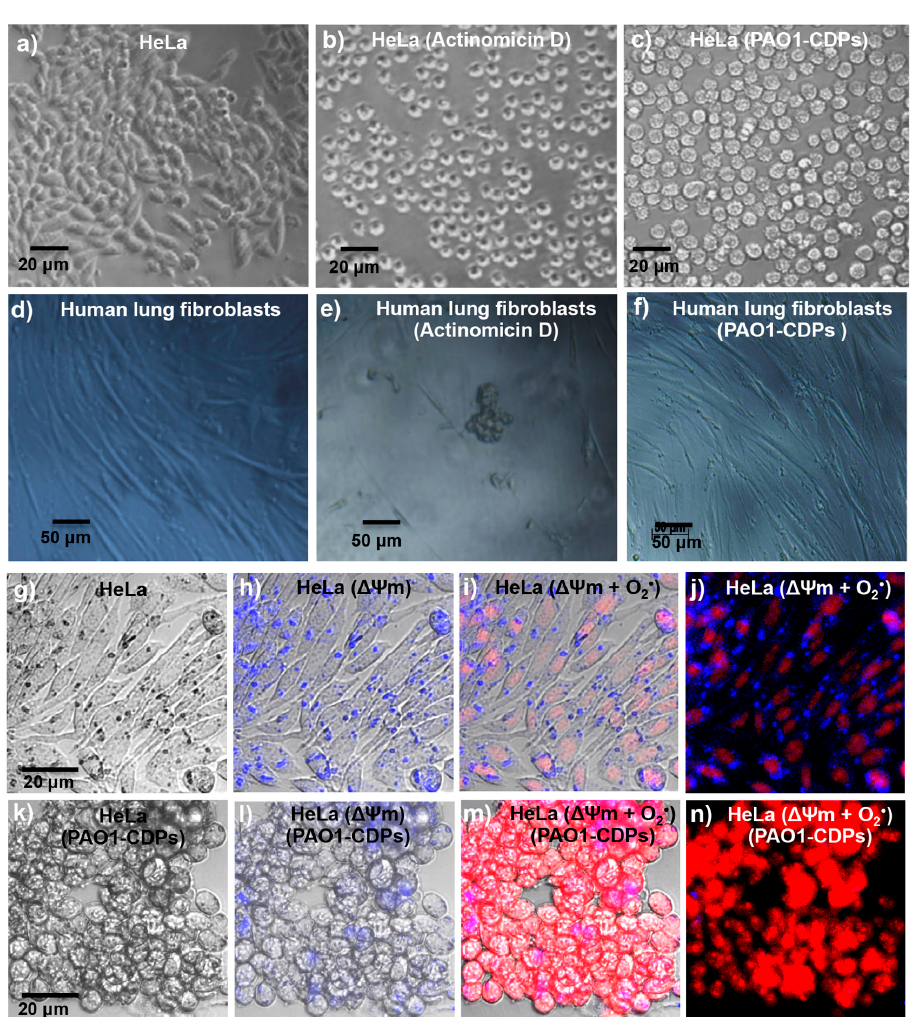
Figure 2. Morphological changes in human cell cultures stimulated with the CDP mixture from